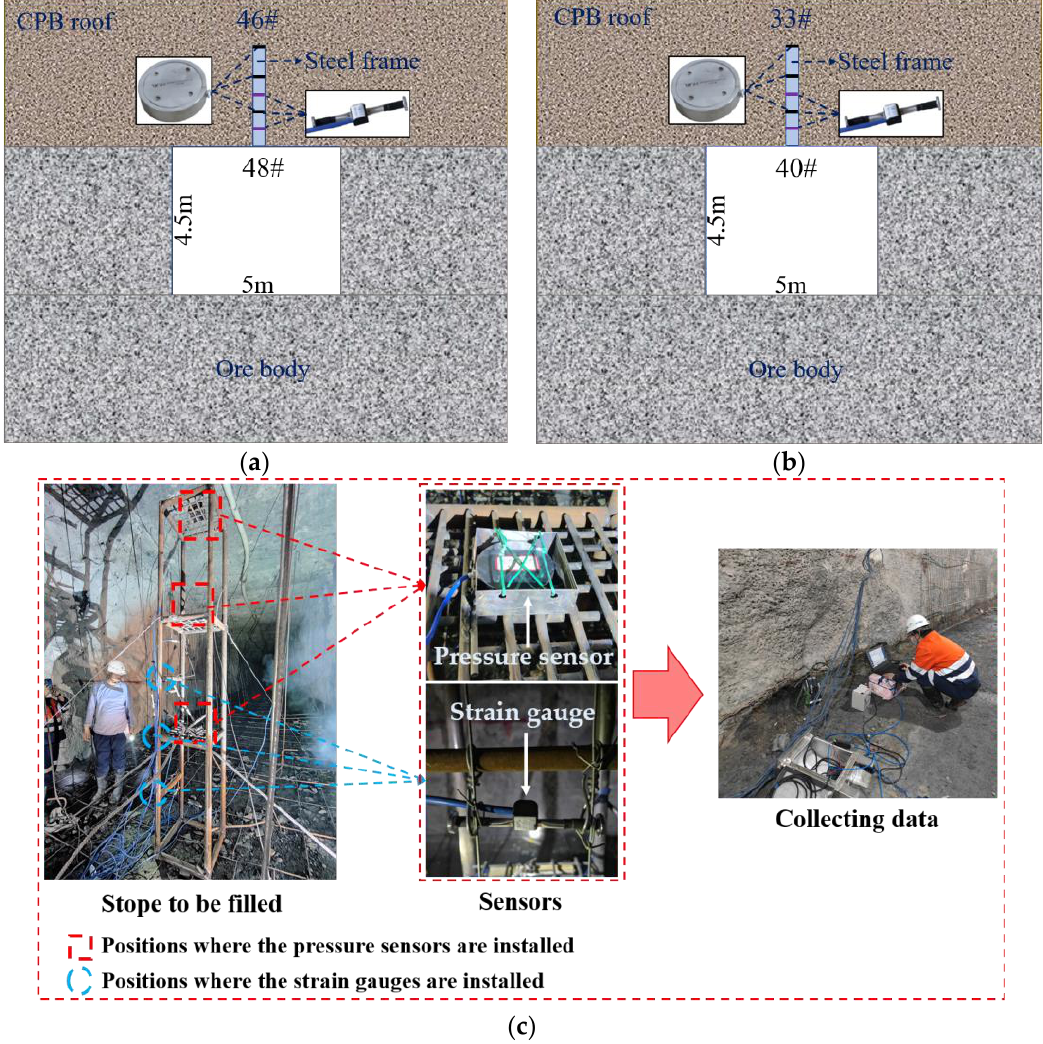
Figure 2. Measurement solutions: ( a ) 48# stope, ( b ) 40# stope, ( c ) measurement process. Table 2. Measurement solutions.